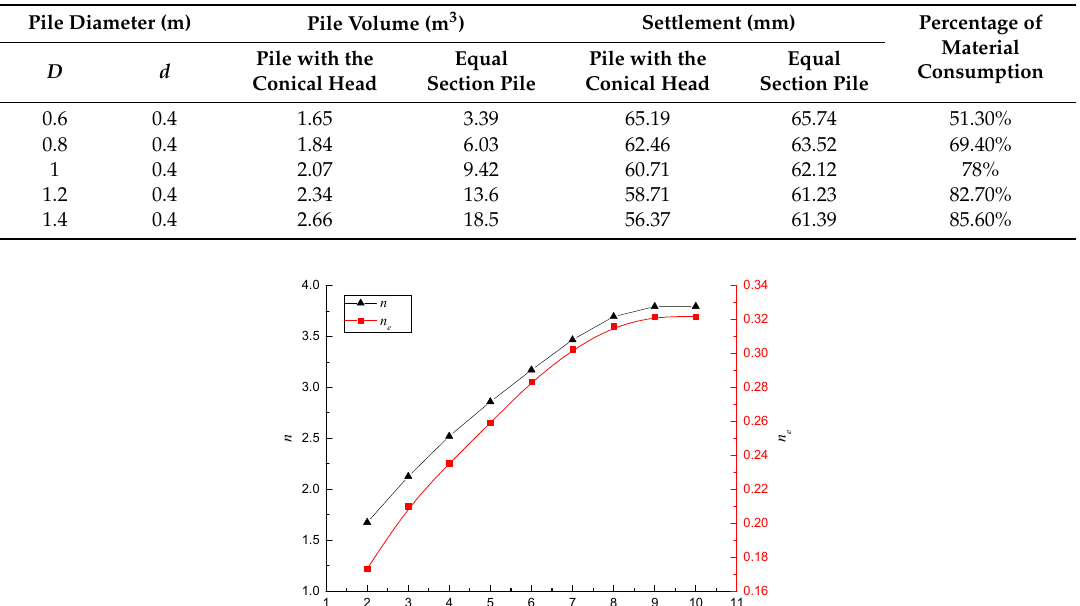
Table 3. Material consumption of the two types of pile and the settlement value.